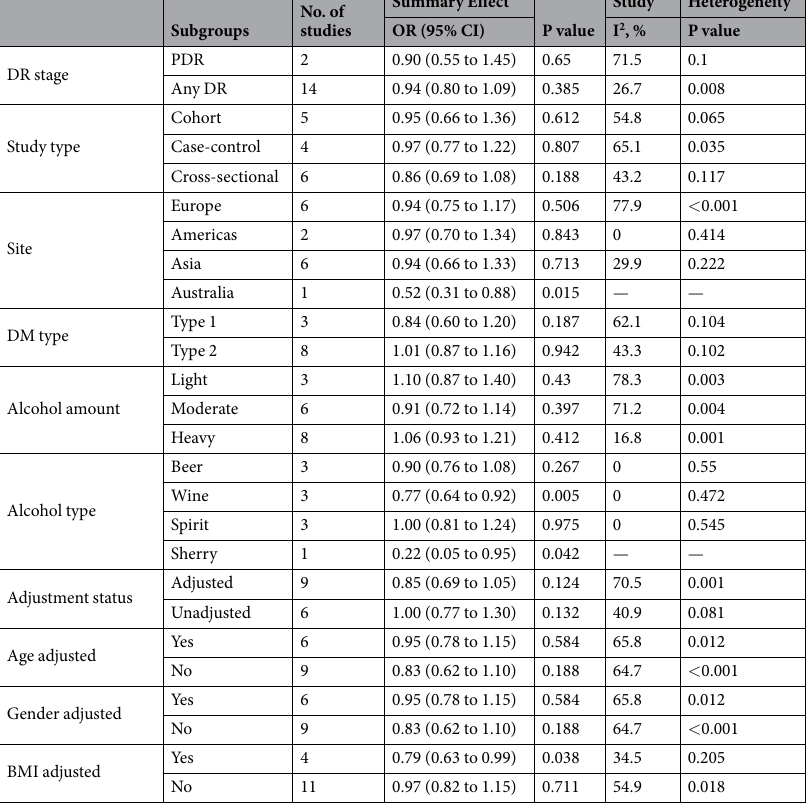
Table 2. Subgroup Analysis of Alcohol Intake and Risk of DR. DM: diabetic mellitus; DR: diabetic retinopathy; OR: odds ratio; CI: confidence